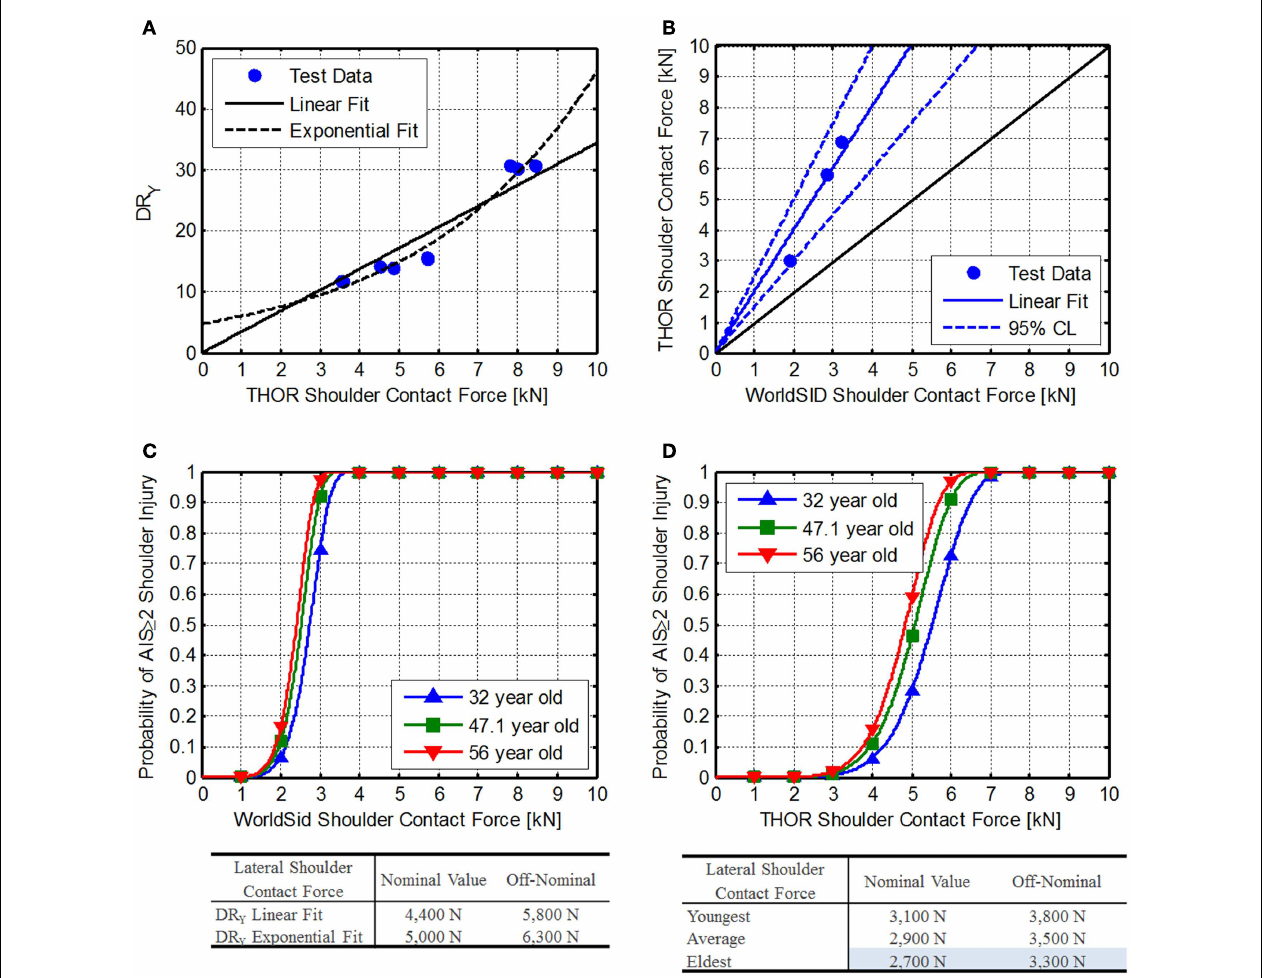
FIGURE 7 | Shoulder contact force . (A) Comparison ofTHOR shoulder contact force related to the BDRC DR y , (B) Comparison ofWorldSID andTHOR shoulder contact force data reported by Pintar et al. (2007), (C) WorldSID injury risk function reported by Petitjean et al. (2012), and (D) developedTHOR shoulder force injury risk